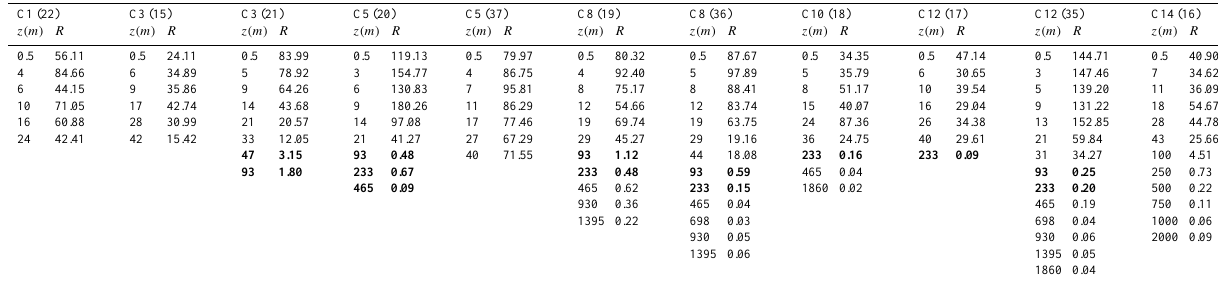
as µmolN 2 h − 1 m − 3 ). C-line 2 or R N depending on 2 2